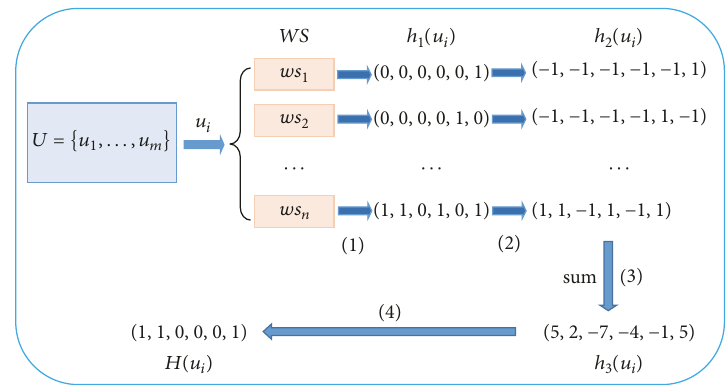
Figure 2: User indexes building procedure in Step 1: an